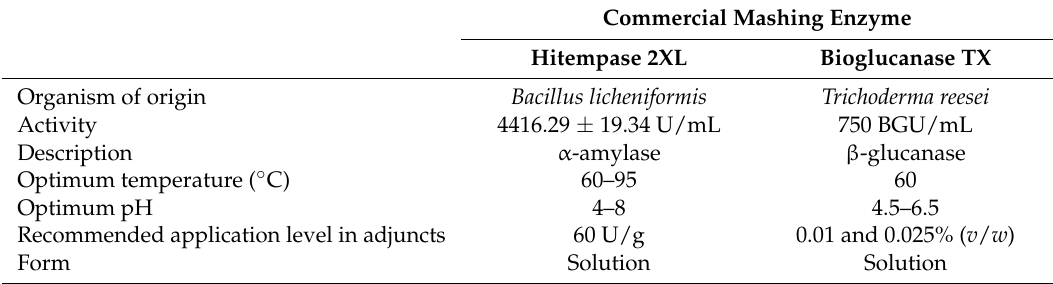
Table 1. Characteristics of commercial enzyme preparations used during